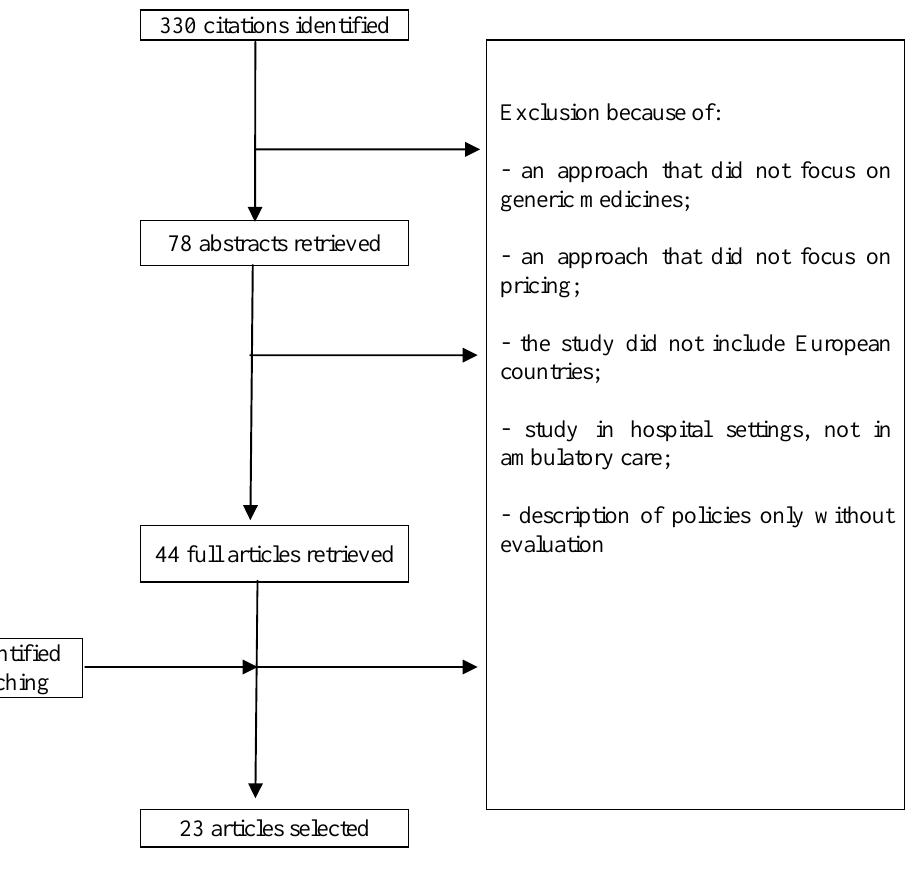
Figure 2. Flow chart of the literature